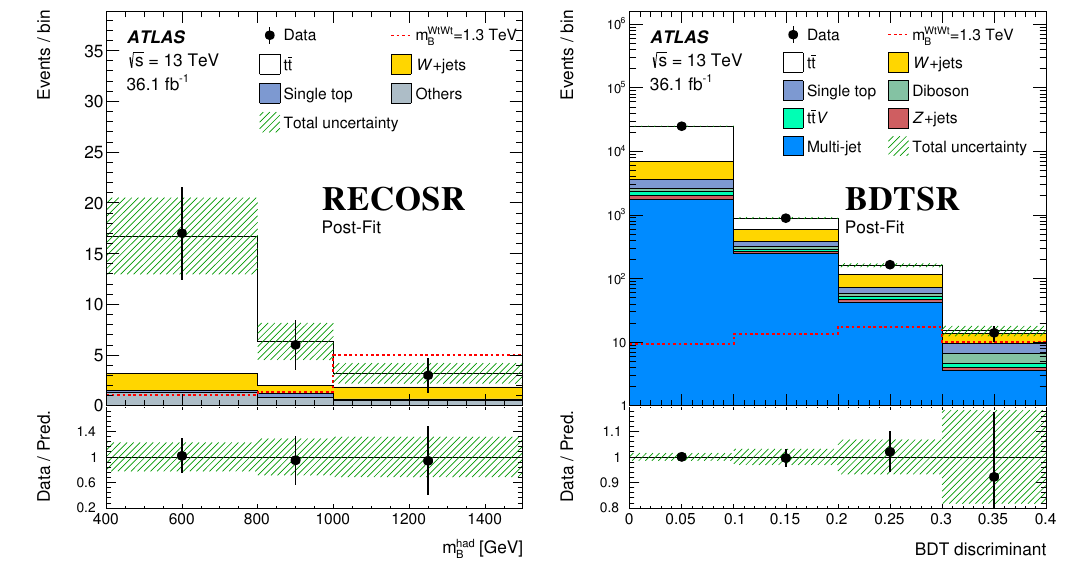
Figure 3 . Fit results (background-only) for the hadronic B quark candidate mass distributions m had (left) and the BDT discriminant in BDTSR (right). The lower panel shows the ratio of data B to the (cid:12)tted background yields. The band represents the total uncertainty after the maximum- likelihood (cid:12)t. Events in the over(cid:13)ow and under(cid:13)ow bins are included in the last and (cid:12)rst bin of the histograms, respectively. The expected B (cid:22) B signal corresponding to m B = 1300 GeV for a branching ratio of 100% into WtWt is also shown